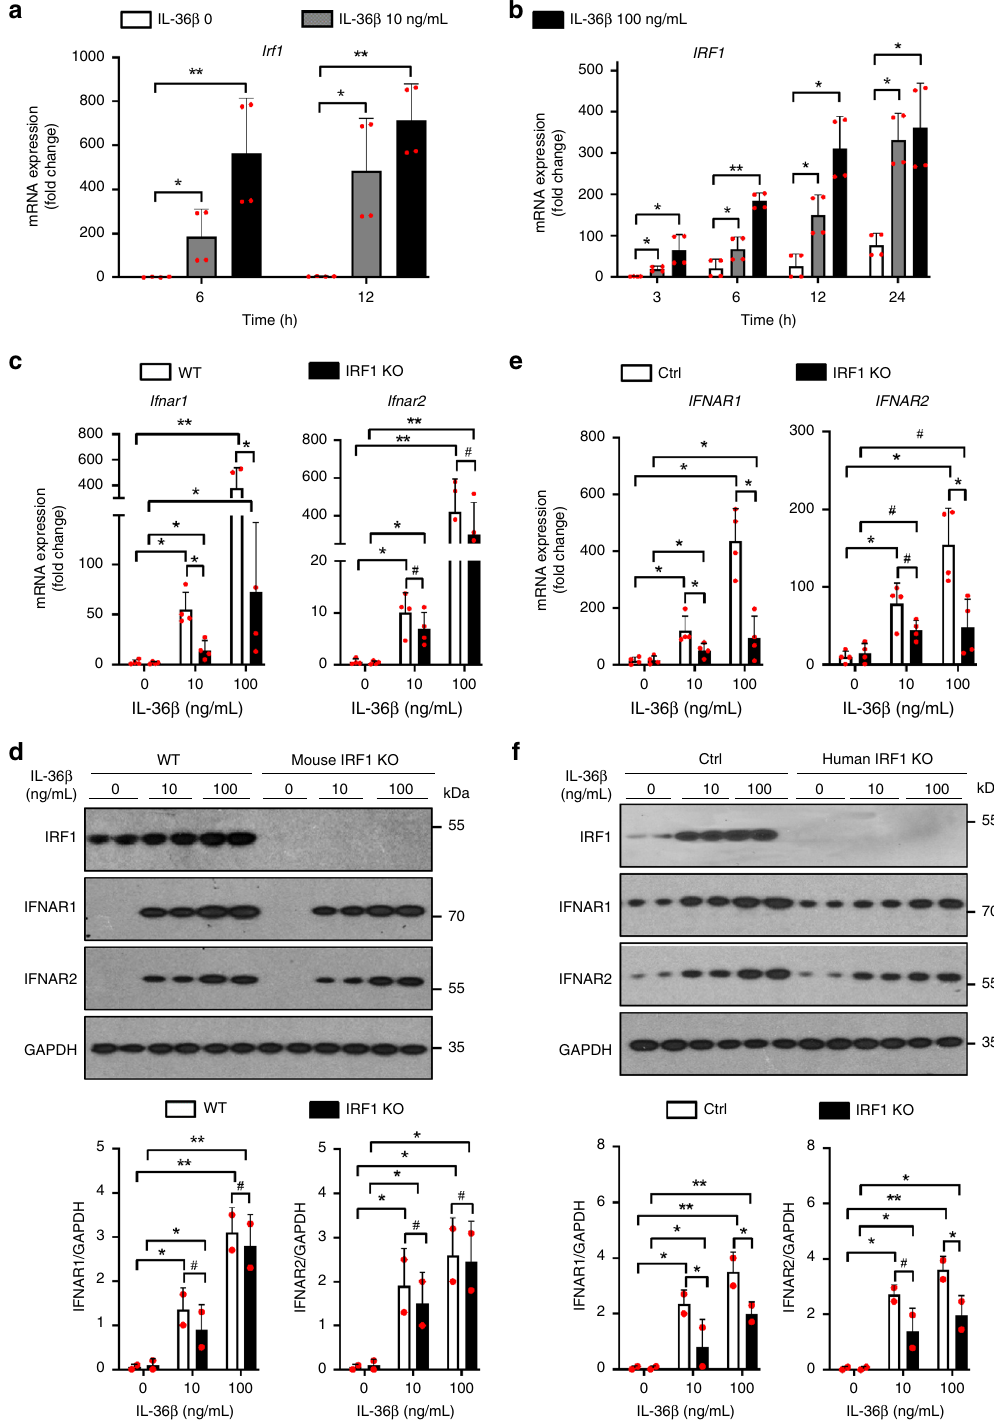
Fig. 6 IRF1 is induced by IL-36 β and has divergent impact on IFNAR expression. a , b IRF1 mRNA expression in mouse ( a ) and human ( b ) keratinocytes was examined following IL-36 β treatment at indicated time-points. c Mouse wild type and IRF1 − / − primary keratinocytes were treated as indicated for 6 h and expression of Ifnar1 and Ifnar2 mRNA analyzed by real-time PCR. d Mouse wild type and IRF1 − / − keratinocytes were treated with medium only or IL-36 β for 6 h and IFNAR protein expression examined by western blotting and ImageJ analyses. e IFNAR1 and IFNAR2 mRNA expression in human control (Ctrl) and IRF1 − / − keratinocytes was examined following medium only or IL-36 β treatment for 6 h. f Protein levels of IFNAR1 and IFNAR2 in human control and IRF1 − / − keratinocytes were determined by western blotting 6 h post-treatment. a – f Quantitative data are shown as means± SD. * p < 0.05; ** p < 0.01; # p > 0.05 (one-way ANOVA, n = 2 biologically independent samples per treatment group). Each red dot represents a single data point. Source data are provided as a Source Data fi